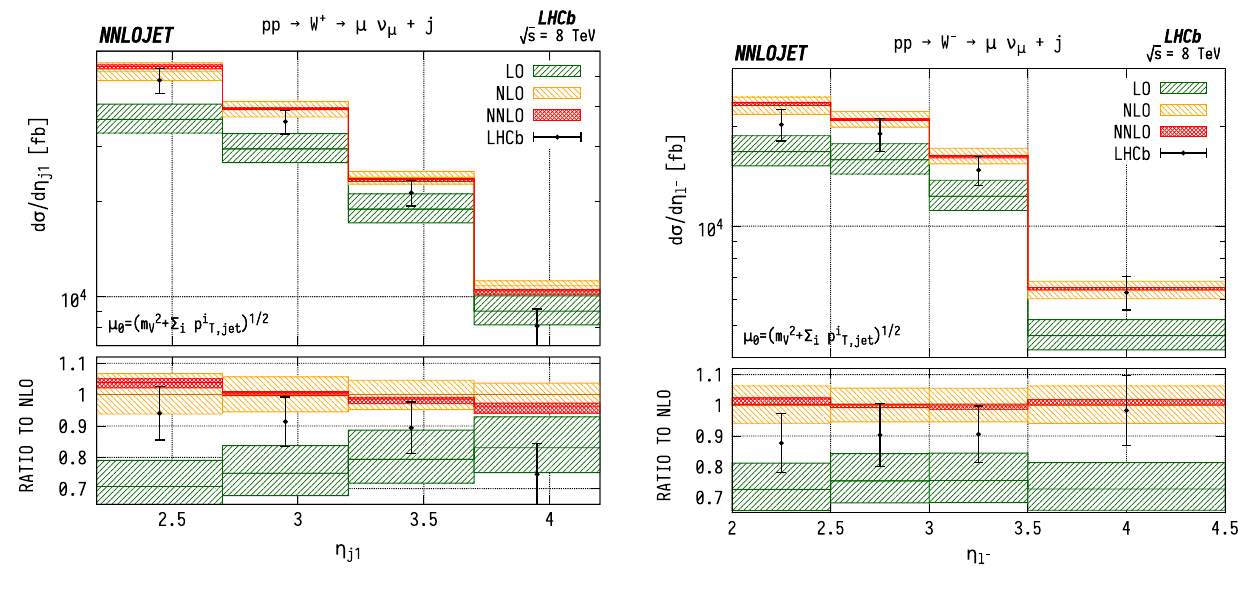
Fig. 9 Cross section differential in the pseudorapidity η of the lepton for W − J production. See Fig. 3 for